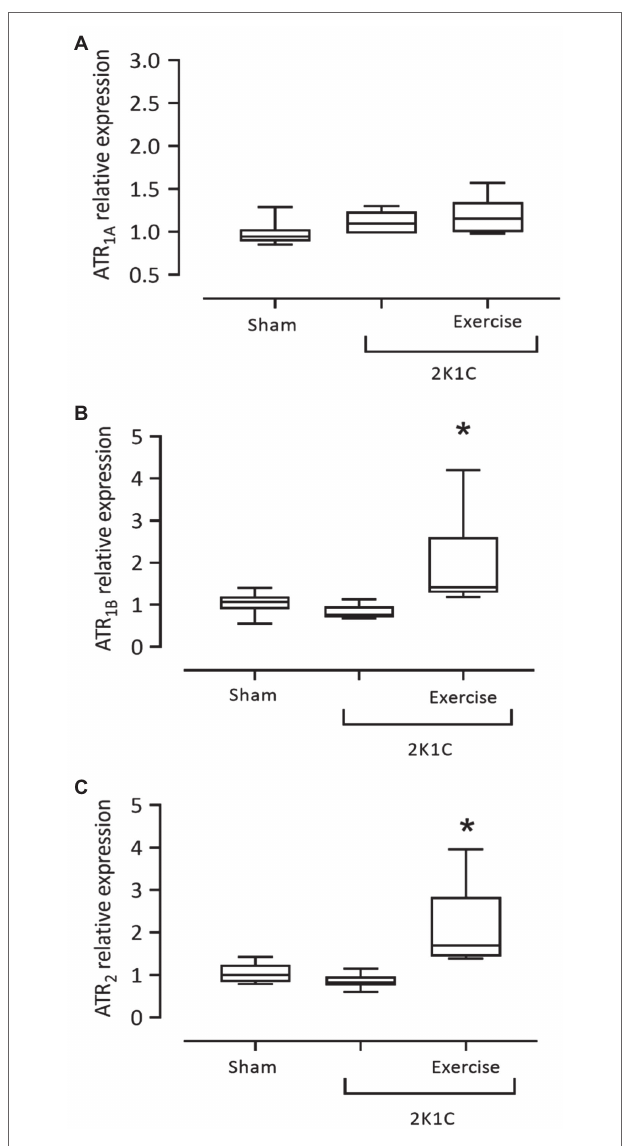
FIGURE 8 | Gene expression of angiotensin II receptors, ATR1A (A) , ATR1B (B) , ATR2 (C) in the duodenum in hypertensive rats by the 2K1C experimental model. Experimental Groups: Sham; 2K1C; 2K1C + Exercise. For statistical analysis, mean ± SEM was used, by Mann-Whitney test. Significance: p <0.05: * vs.